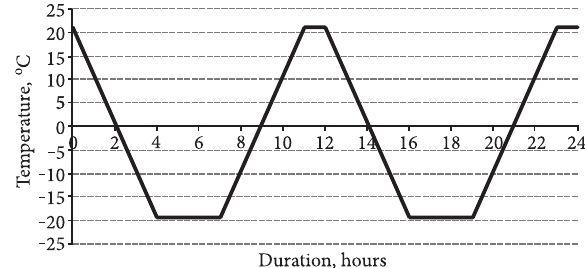
Fig. 2. The function of freeze-thaw cycles and temperature changes according to CEN/TS 12390-9 CDF method Table 4. Density of paving blocks